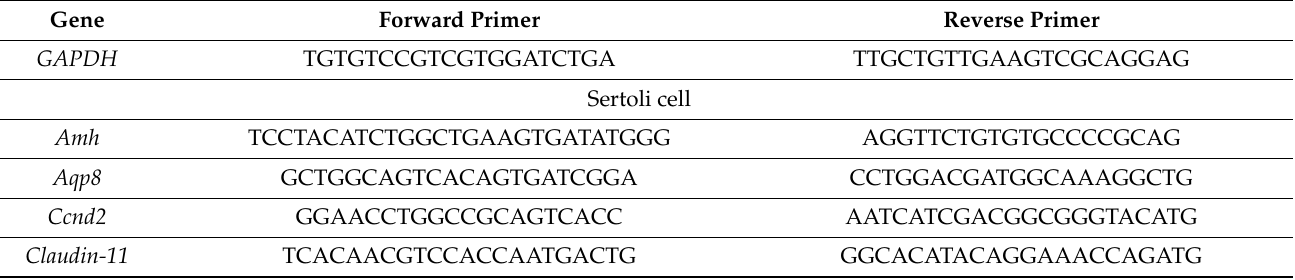
Table 1. Primers used for real-time